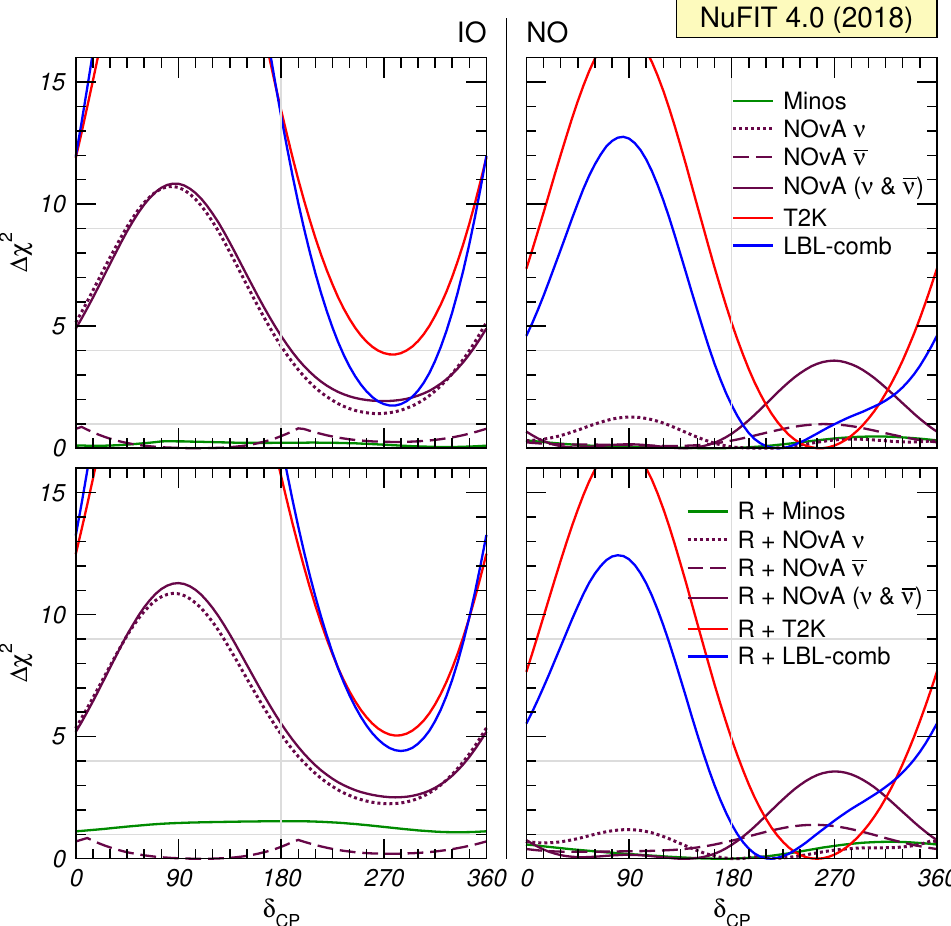
Figure 8 . (cid:14) CP determination from LBL, reactor and their combination. Left (right) panels are for IO (NO). The upper panels show the 1-dim (cid:1) (cid:31) 2 from LBL experiments after constraining only (cid:18) 13 from reactor experiments. For each experiment (cid:1) (cid:31) 2 is de(cid:12)ned with respect to the global minimum of the two orderings. The lower panels show the corresponding determination when the full information of LBL accelerator and reactor experiments on both mixing angles and (cid:1) m 2 is 3 ‘ used in the combination. In all panels (cid:1) m 2 , sin 2 (cid:18) 12 are (cid:12)xed to the global best (cid:12)t 21